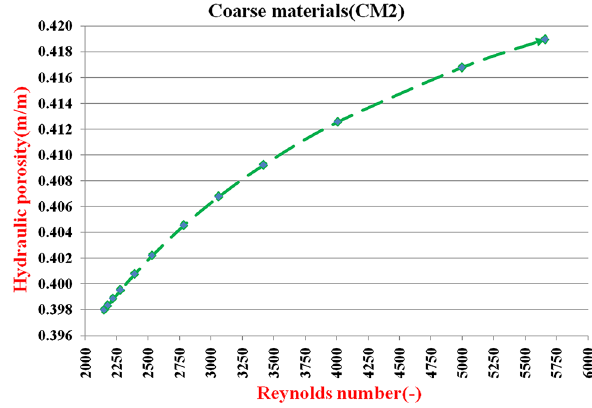
Fig. 6 Variation of hydraulic porosity versus Reynolds number for CGM2 with d m = 30.40 mm